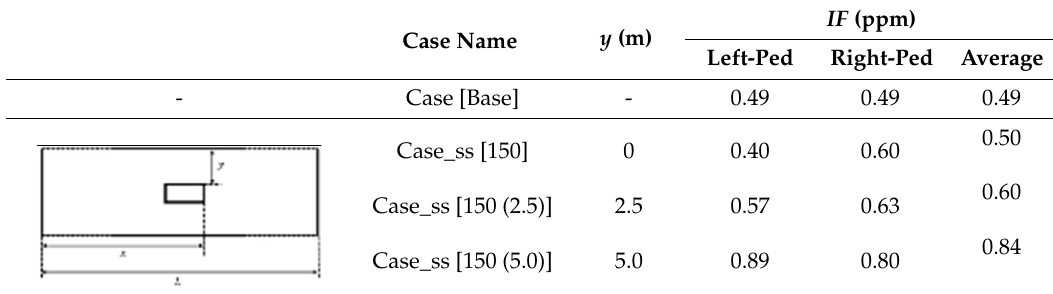
Table 6. Intake Fraction ( IF ) in cases with a single small catcher at 150 m.